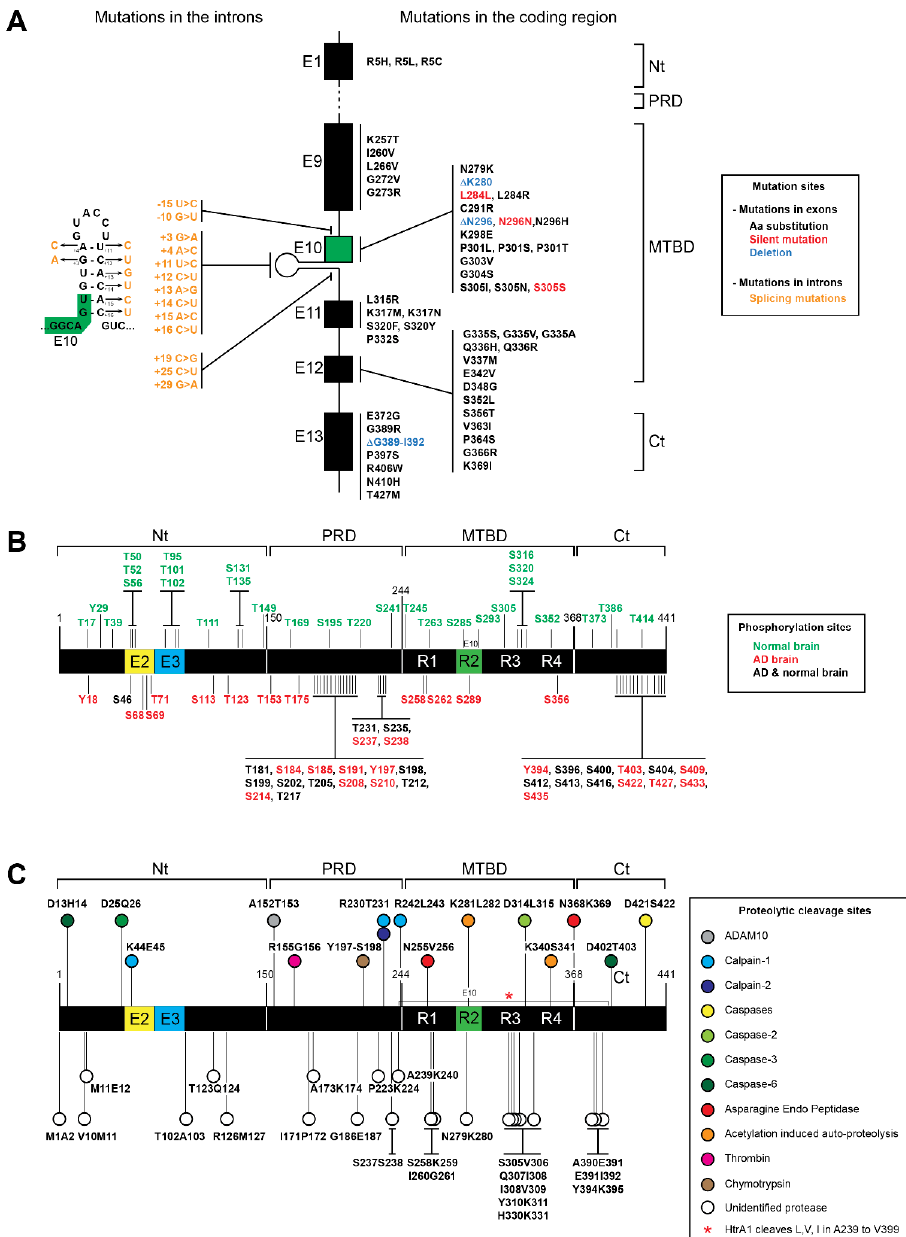
Figure 2. Tau proteins, mutations, phosphorylation and truncation sites. ( A ) Mutations found in tau associated with neurodegenerative diseases. The most frequent mutations are found in the microtubule binding domain (MTBD) and in the C-terminal domain (Ct). Single amino acid substitutions are shown in black, deletions are shown in blue, and silent mutations are shown in red. Several mutations (shown in orange) that affect splicing are also found in the introns flanking exon 10 (shown in green). The mutations are also shown on the intron hairpin that is located close to exon 10 ( B ) The phosphorylation sites that have been found only in normal brain are shown in green above the graphic representing tau protein; phosphorylation sites found only in Alzheimer’s disease (AD) patients are shown in red under the graphic, and phosphorylation sites found in both AD and normal brain are shown in black. ( C ) Cleavage sites by identified proteases are shown above the graphic of tau protein. The color code of the corresponding proteases is indicated in the figure. Other cleavage sites that have been generated by yet unidentified proteases are shown under the graphic and represented by white